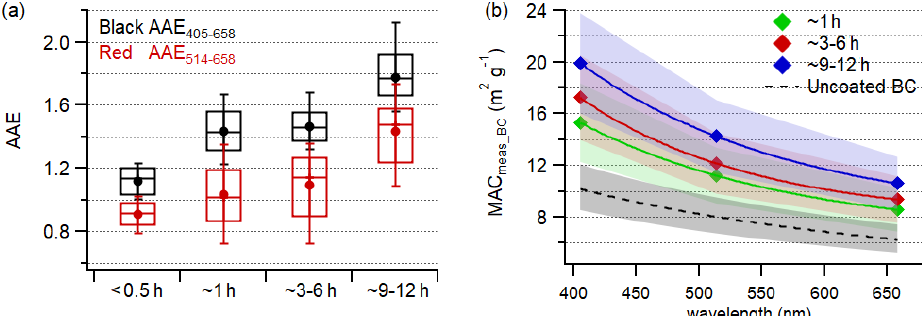
Figure 6. (a) The measured AAE 405 − 658 (black) and AAE 514 − 658 (red) in sampled smoke plumes at different ages. The box-and-whisker plots represent the 10th percentile, 25th percentile, median, 75th percentile and 90th percentile, and the dot markers represent mean values. (b) The measured MAC values (markers) with uncertainties (shades) at 405, 514 and 658nm in sampled smoke with different ages; the black dashed lines and shaded areas represent the MAC and uncertainties of uncoated BC reported by Bond and Bergstrom